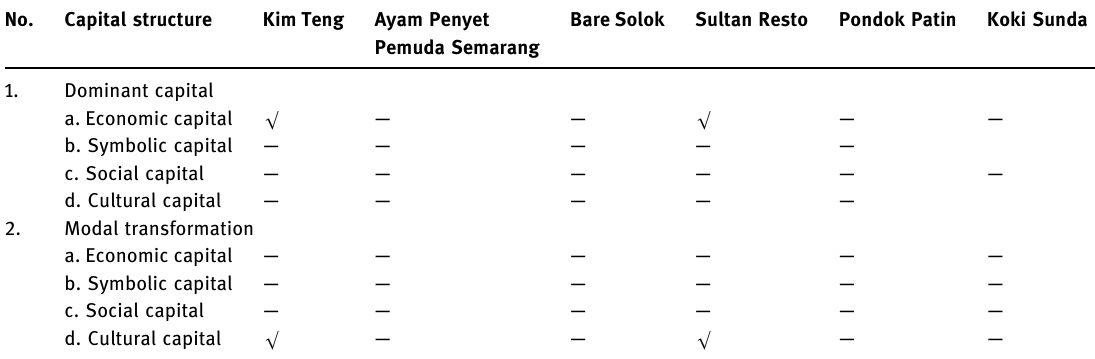
Table 3: The fi eld of culture and history